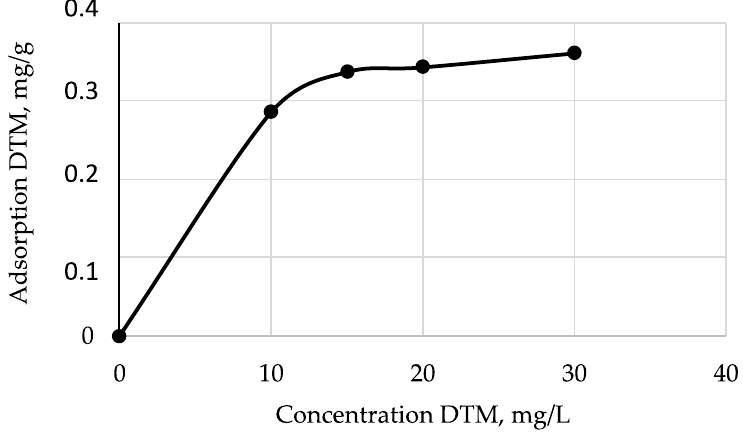
Figure 5. DTM adsorption isotherm on molybdenite.